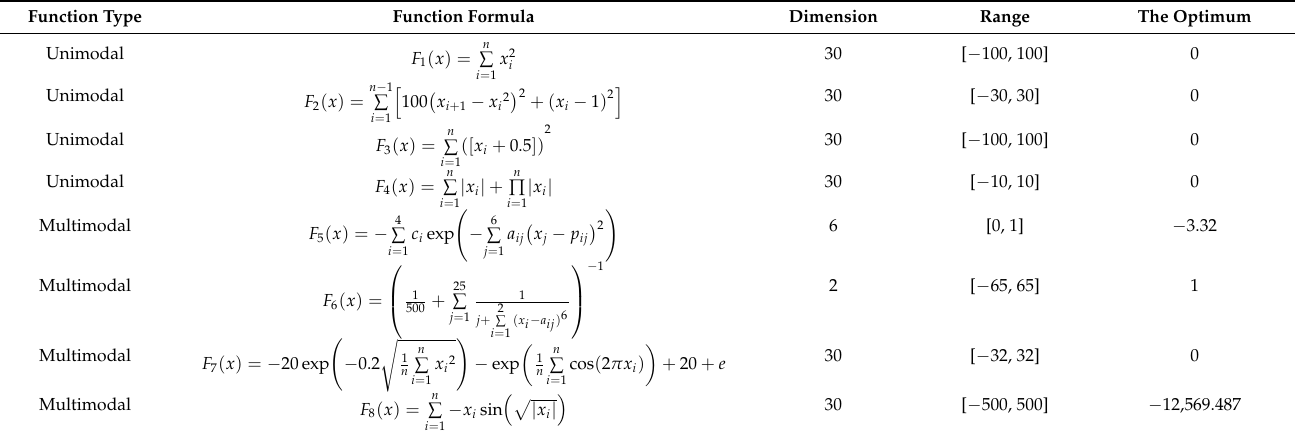
Table 1. Test function information.